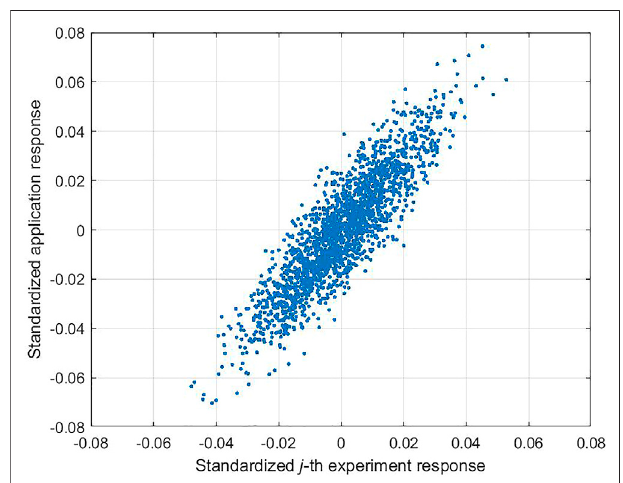
FIGURE 3 | Representative scatter plot of two perturbation